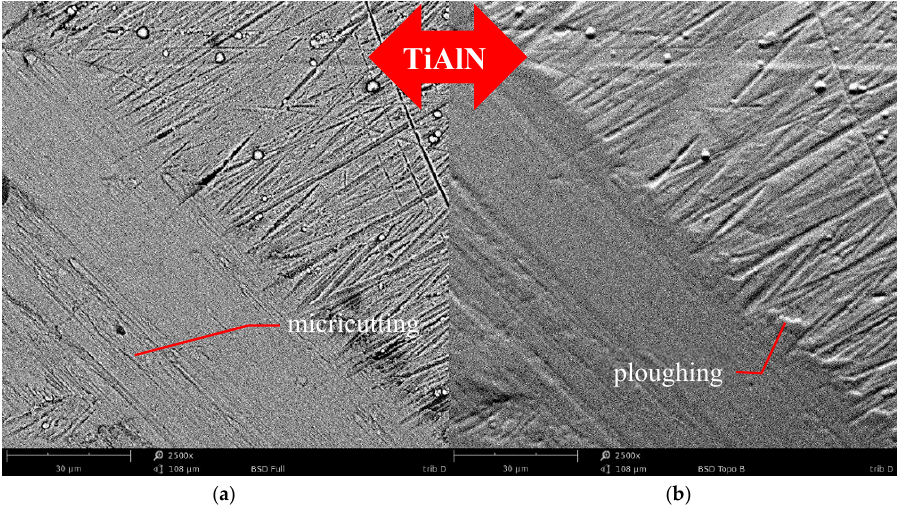
Figure 12. Wear trace on the TiAlN film: ( a ) SEM ‐ BSD and ( b ) SEM ‐ topo, 2500x.